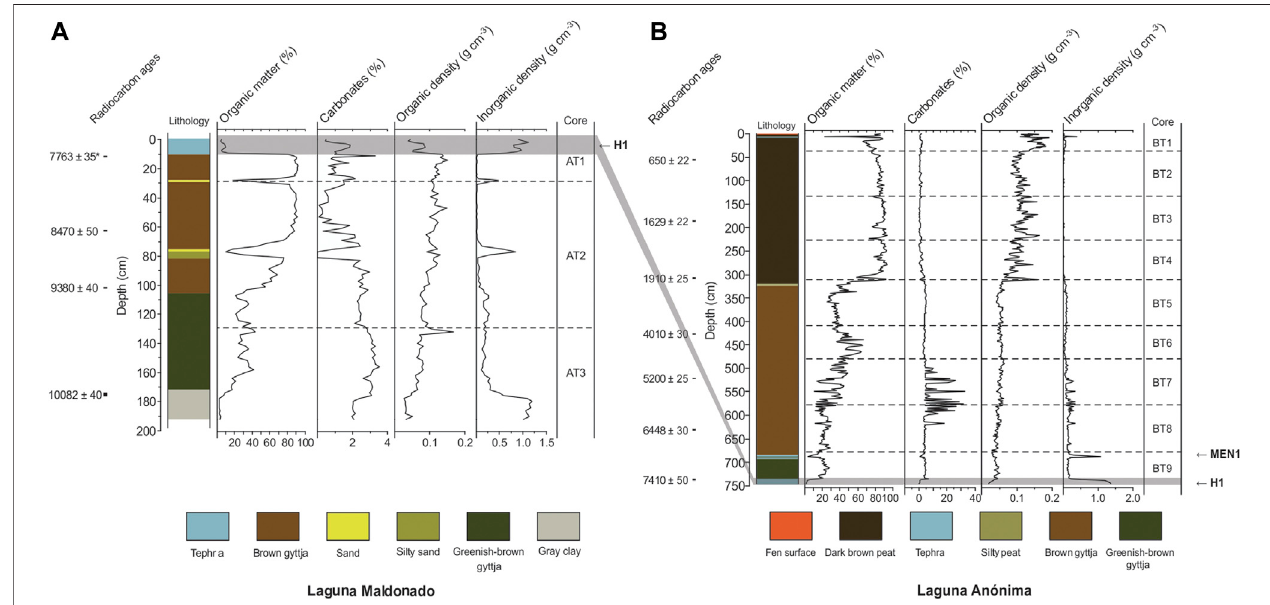
FIGURE 2 | Radiocarbon ages, lithology, and loss-on-ignition results of (A) LMA0608B and (B) LLA 0607A cores. Letters represent tephra layers described by Stern et al. (2016), and dashed horizontal lines indicate the core boundaries.